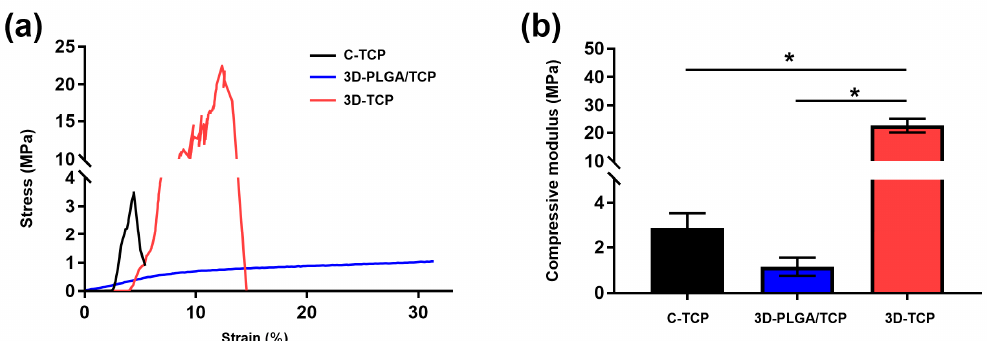
Figure 3. Mechanical properties of C-TCP, 3D-PLGA / TCP, and 3D-TCP sca ff olds. ( a ) Compressive strain–stress curves indicated that 3D-PLGA / TCP possessed flexible mechanical properties. ( b ) E ff ects of 3DP and β -TCP amounts on the compressive modulus (* p <